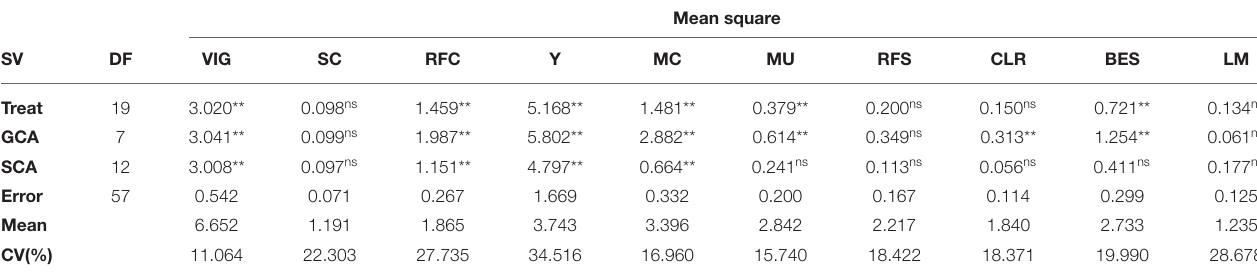
TABLE 6 | Analysis of variance for 10 traits, evaluated in eight parents of arabica coffee and their hybrids obtained by a circulating diallel scheme.